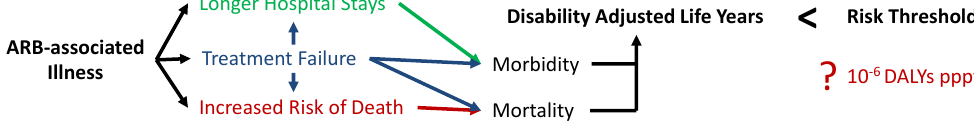
Figure 1. An overview on how the classical quantitative microbial risk assessment framework can be applied to understand and assess the risks from antibiotic resistant bacteria and genes.